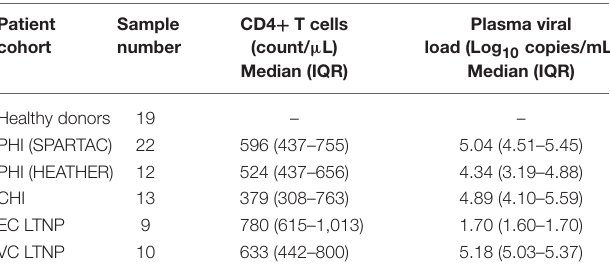
TABLE 1 | Sample cohort